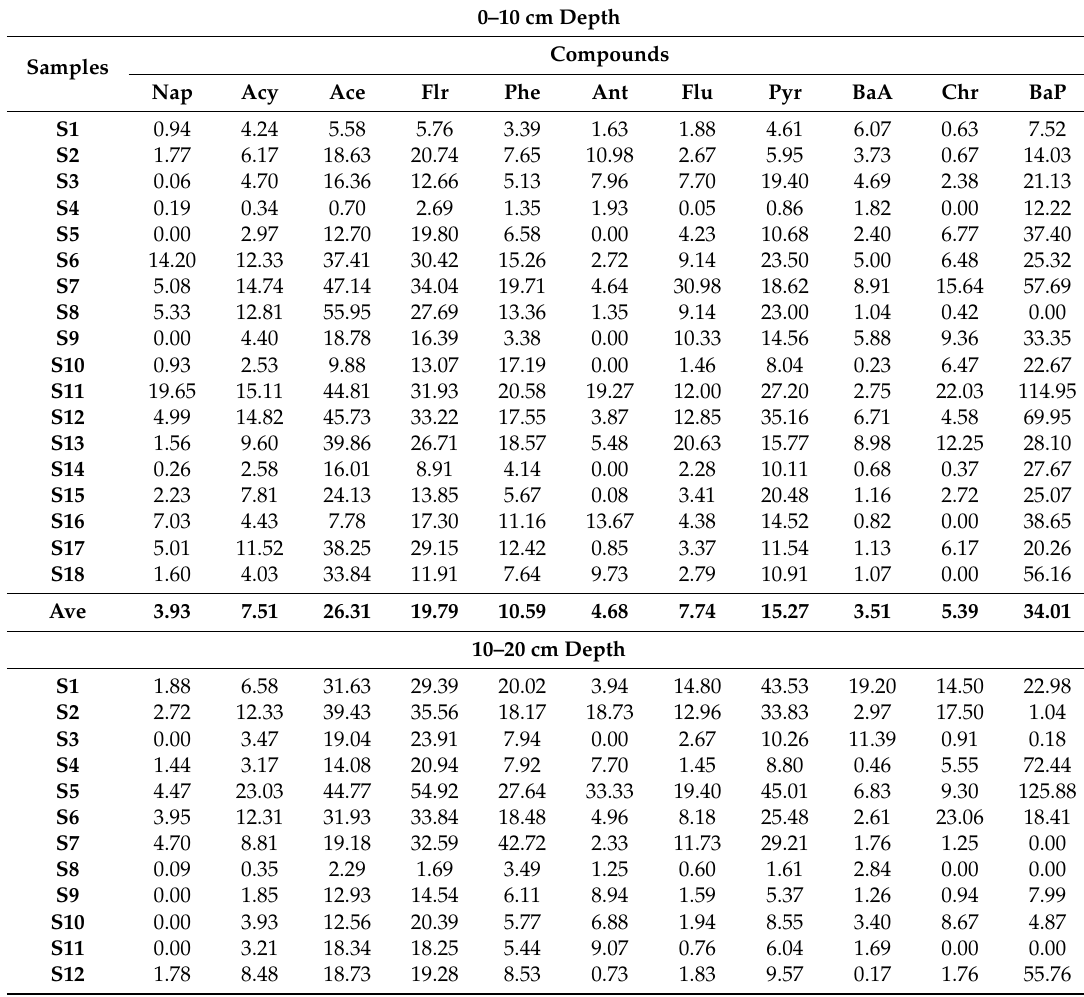
Table A1. The concentrations of individual PAHs ( µ g kg − 1 ) in all samples and at the two respective soil